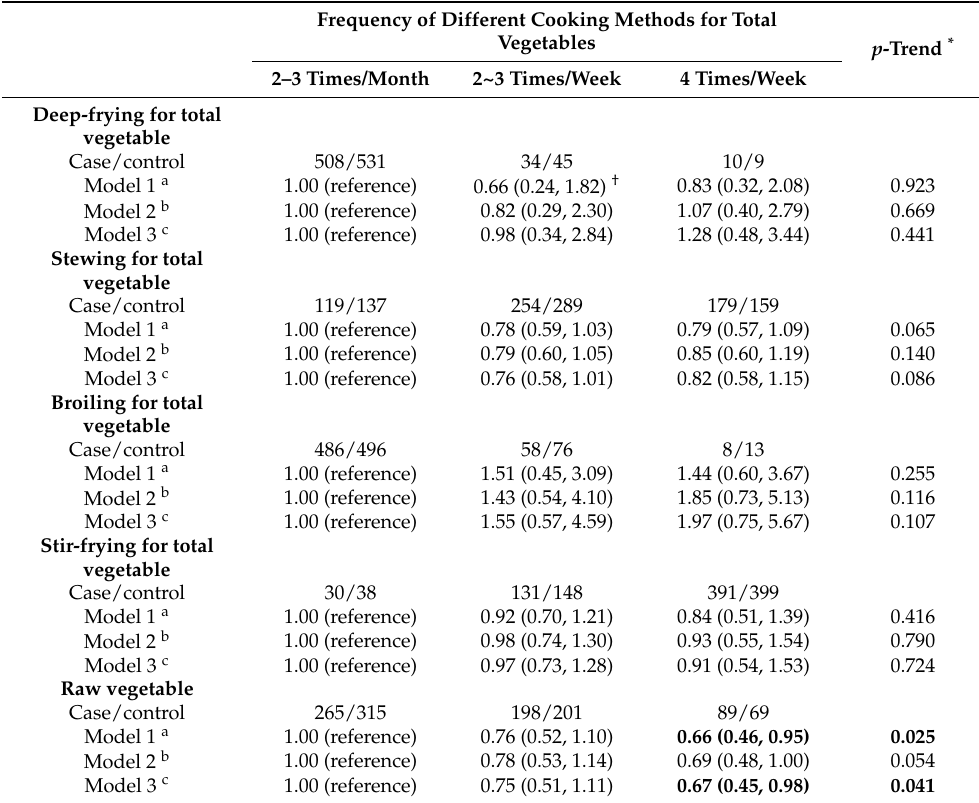
Table 4. Association between different cooking methods for total vegetables and asthenozoospermia. Frequency of Different Cooking Methods for Total Vegetables p -Trend * 2–3 Times/Month 2~3 Times/Week 4 Times/Week Deep-frying for total